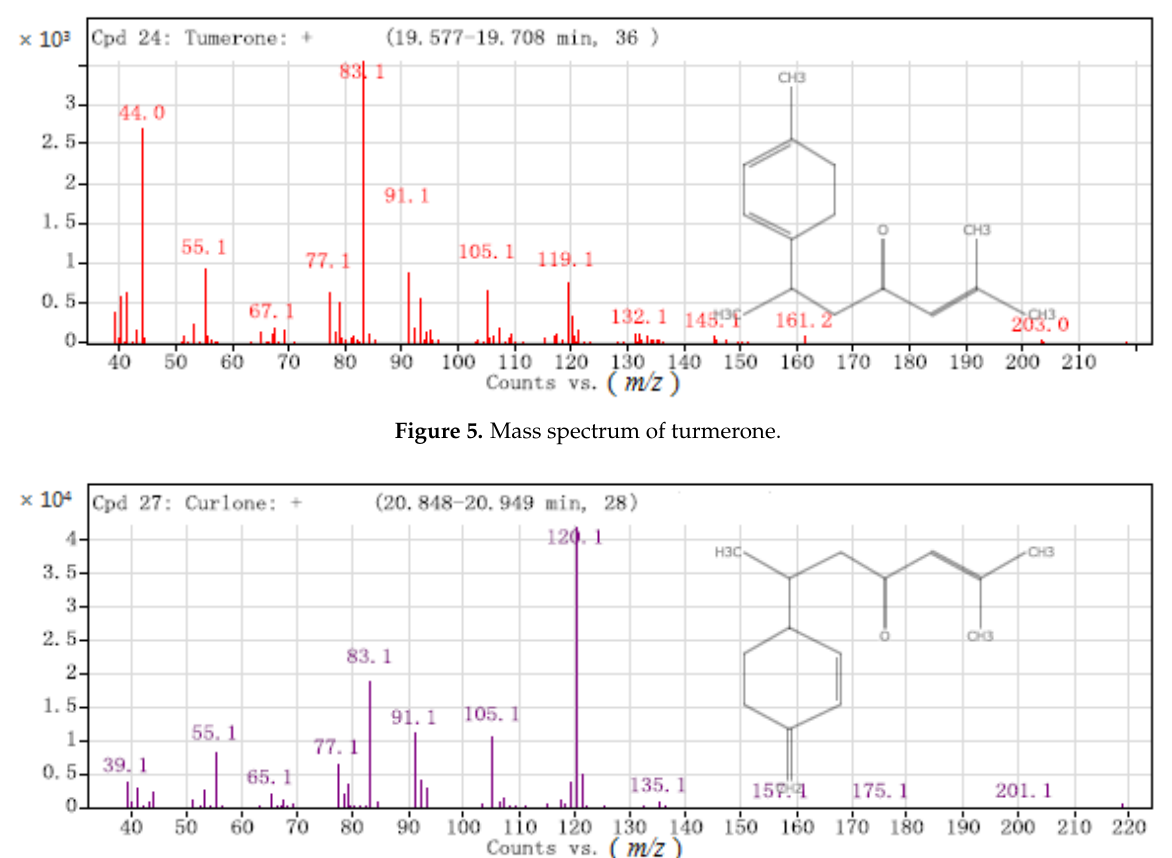
Figure 4. Mass spectrum of ar-turmerone.